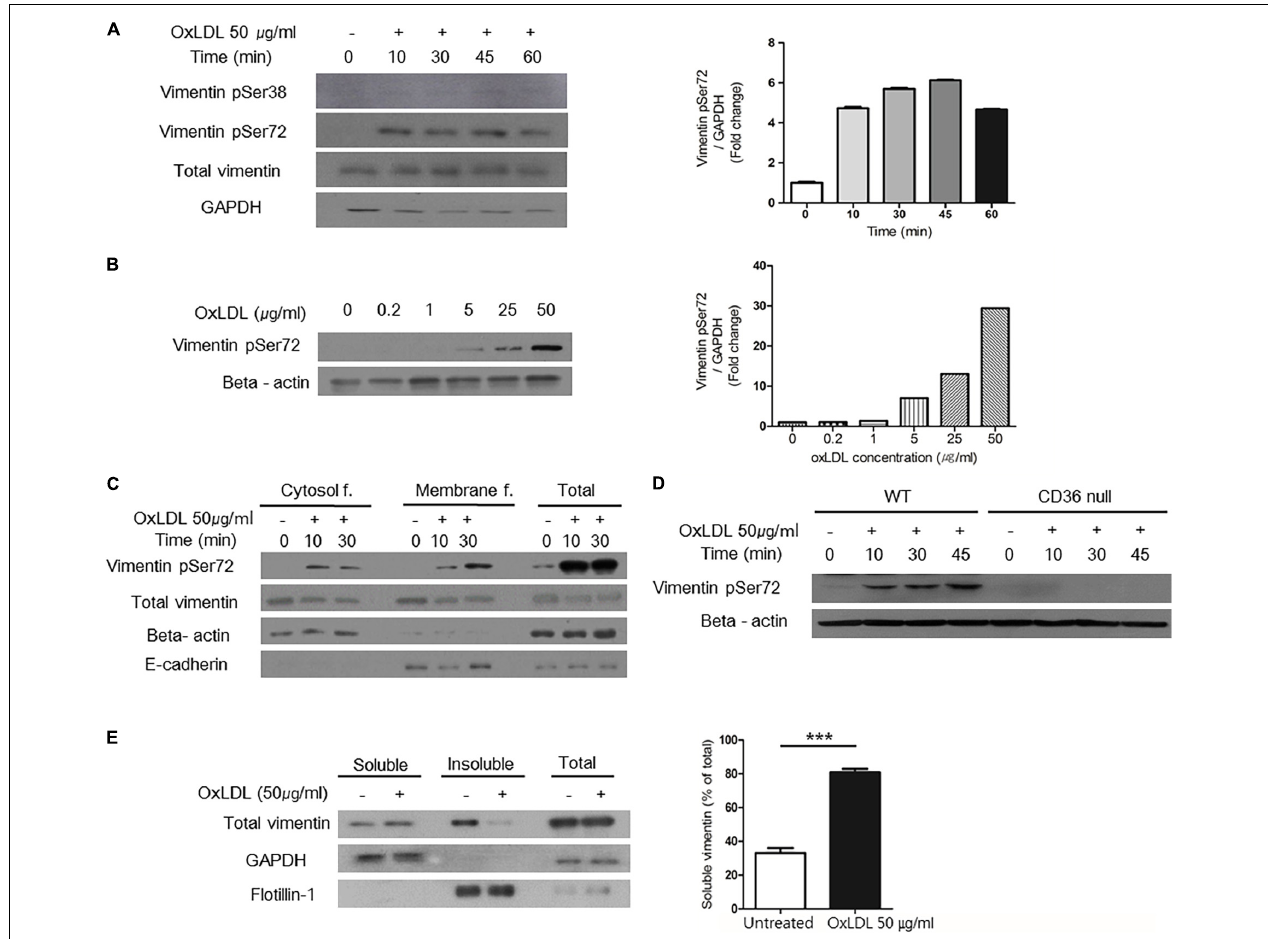
FIGURE 4 | OxLDL-induced vimentin (Ser72) phosphorylation depended on CD36 and led to disassembly of vimentin filaments. (A) Western blots for phosphorylated vimentin (Ser72) and phosphorylated vimentin (Ser38) using cell lysates of wild type murine peritoneal macrophages. Cells were treated with oxLDL (50 µ g/ml) for indicated times. (B) Western blot for phosphorylated vimentin (Ser72) using cell lysates of wild type murine peritoneal macrophages. Cells were treated with various concentrations of oxLDL for 10 min. (C) Wild type murine peritoneal macrophages were incubated with OxLDL (50 µ g/ml) for indicated times. Cytosolic and membrane fractions were separated using buffer-based protocol. E-cadherin was used as a marker for plasma membrane fraction and beta actin was used as a marker for cytosolic fraction. (D) Wild type and CD36 null murine peritoneal macrophages were incubated with myeloperoxidase (MPO)-modified LDL (oxLDL, 50 µ g/ml) for indicated times. The lysates were analyzed by western blot for phosphorylated vimentin (Ser72). (E) Macrophages were treated with oxLDL (50 µ g/ml) for 10 min. Cytosolic fraction is divided based on the solubility in triton X-100. Western blot for vimentin was done. GAPDH was used as a marker for soluble fraction and flotilin-1 was used as a marker for insoluble fraction. *** p < 0.001. The graph shows mean ± SEM for triplicated determinants of the